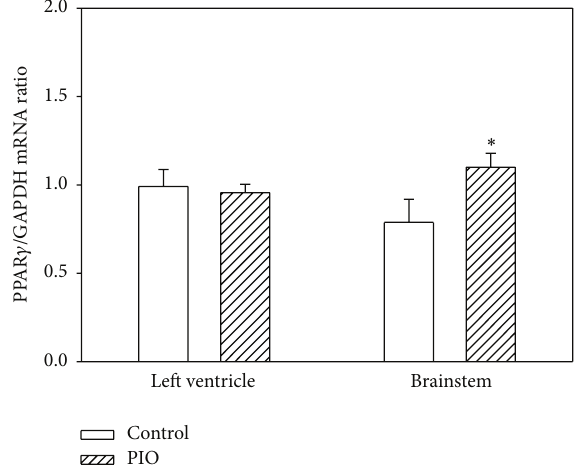
Figure 4: Effect of pioglitazone administration on PPAR 𝛾 expres- sion in different tissues of young SHRs. PPAR 𝛾 expression was normalized to expression of GAPDH as a housekeeper gene. Data areshownforleftventricleandbrainstemandbarsrepresentmean ± SEM, 𝑛 = 7 . ∗ 𝑃 < 0.05 , PIO versus